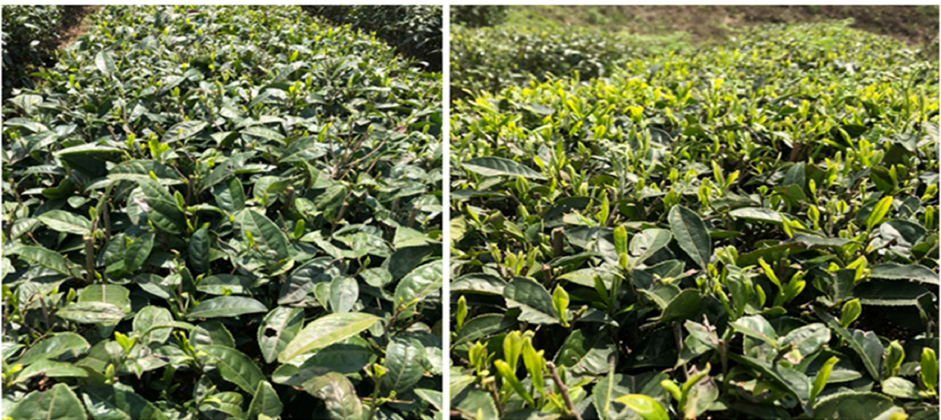
Figure 1. Tea plants treated by 5% COS bearing more new shoots (left: CK; right: COS-treated). The bud dentistry in three different area were detected as shown in Figure 2 with average numbers of buds 1433.33, 1263.33 and 1843.33, respectively, which were increased by 18.46%, 13.81% and 23.16% when comparing with the CK. The average weight of 100-buds was 7.75 g, 8.64 g and 6.52 g, respectively, which increased by 16.23%, 18.15% and 15.94% compared with the CK.